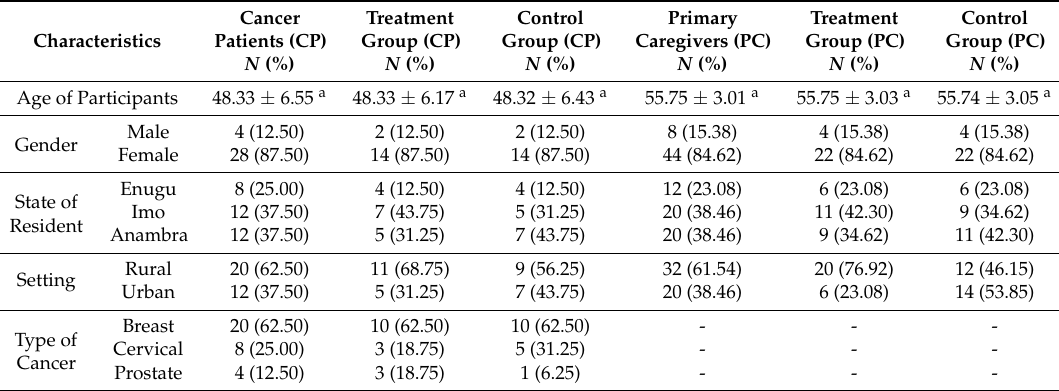
Table 1. Sociodemographic information of the